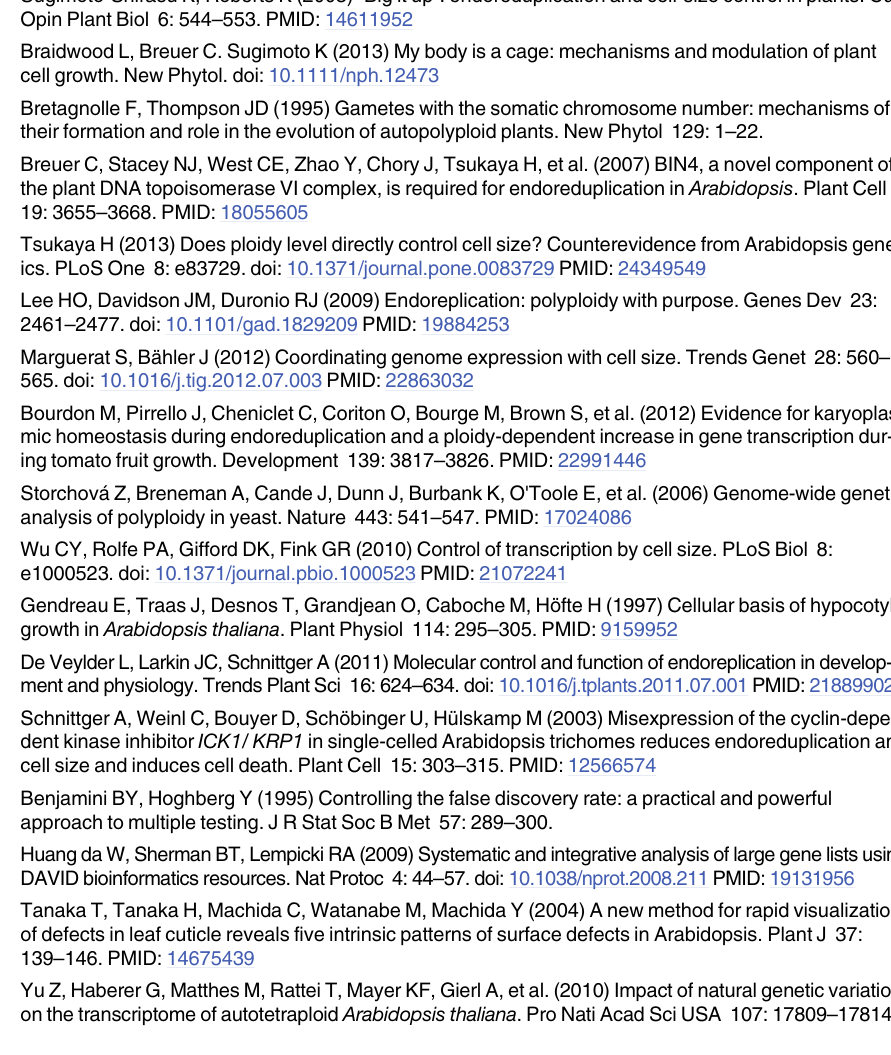
S4 Table. Repressed gene groups associated with lipid transport/localization/binding in tet- raploid